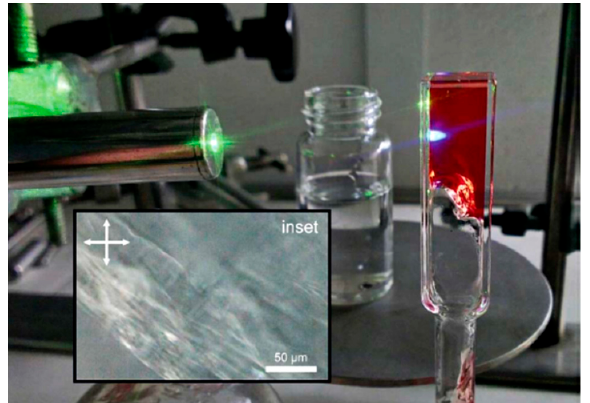
Figure 1. A photograph of 1,3:2,4-bis(3,4-dimethylbenzylidene) sorbitol (DMDBS)-palladium tetraphenylporphyrin (PdTPP)-9,10-diphenylanthracene (DPA) organogel in deaerated tetralin showing green-to-blue upconversion in an inverted cuvette. Adopted with permission from [33] Copyright 2015 Royal Society of